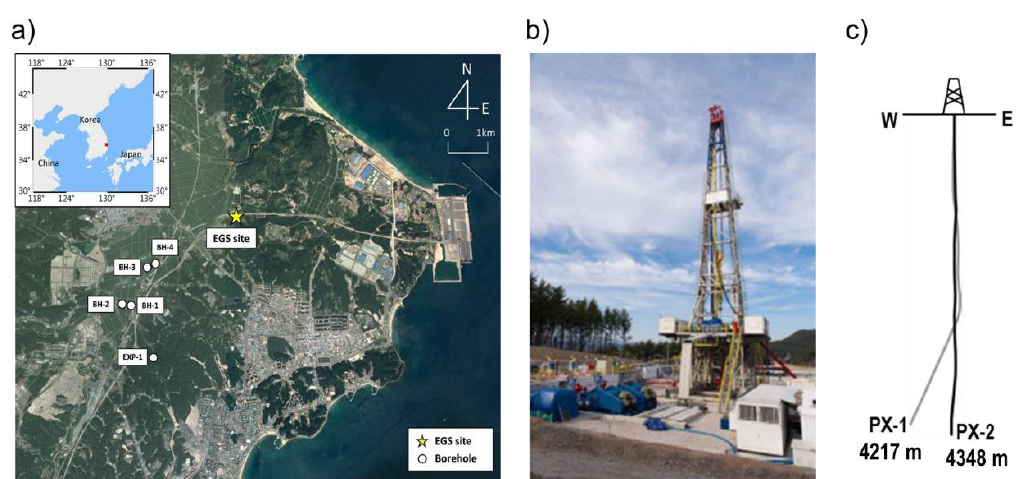
Figure 1. ( a ) Pohang Enhanced Geothermal System (EGS) project location. ( b ) Photo of a well drilling rig, and ( c ) schematic of wells PX-1 and PX-2 depths.